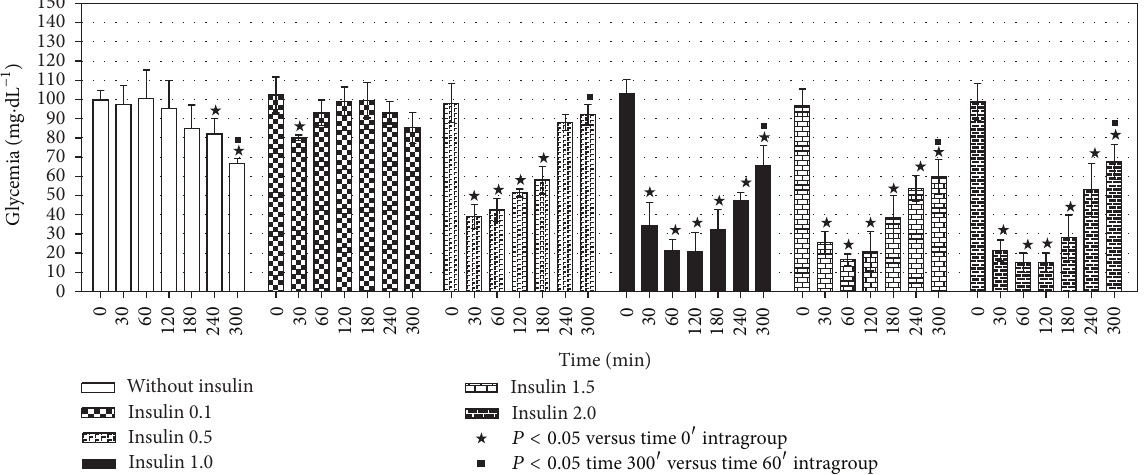
Figure 2: Glycemic response as a function of dose and time after intraperitoneal injection of regular insulin in 14hr fasted mice. In these experiments saline or increasing doses of insulin (0.1, 0.5, 1.0, 1.5, and 2.0U ⋅ kg −1 ) were injected. Glycemia was measured (mg ⋅ dL −1 ) 0, 30, 60, 120, 180, 240, and 300 min after insulin injection. Bars are mean ± standard deviation of 6–8 experiments. 󳀅 𝑃 < 0.05 versus 0min; ◼ 𝑃 < 0.05 300 min versus 60min.